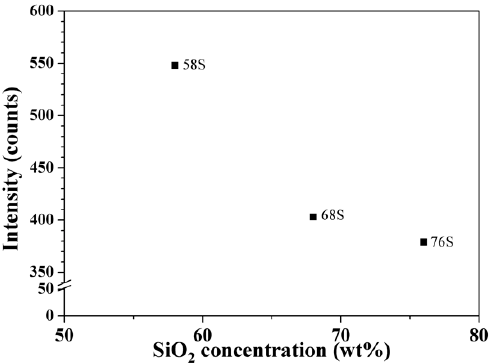
Figure 7 Intensities of hydroxyapatite (HA) (112) peak as a function of SiO 2 concentration.